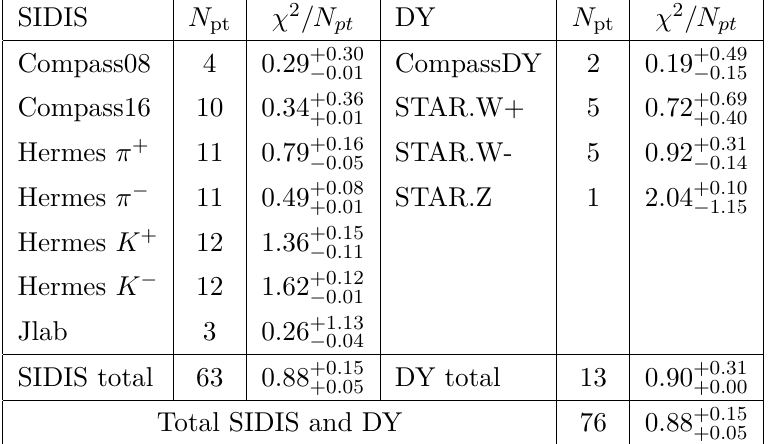
Table 3. Distribution of χ 2 values over the data sets. The results are for the fit SIDIS+DY at N 3 LO. For other fits the distributions are analogous.